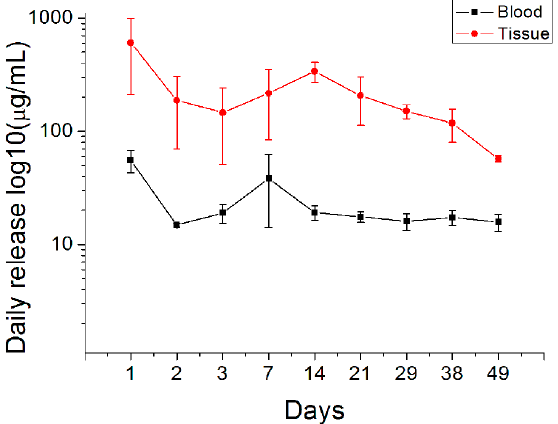
Figure 10. In vivo release curves of fluconazole from the drug-loaded beads.